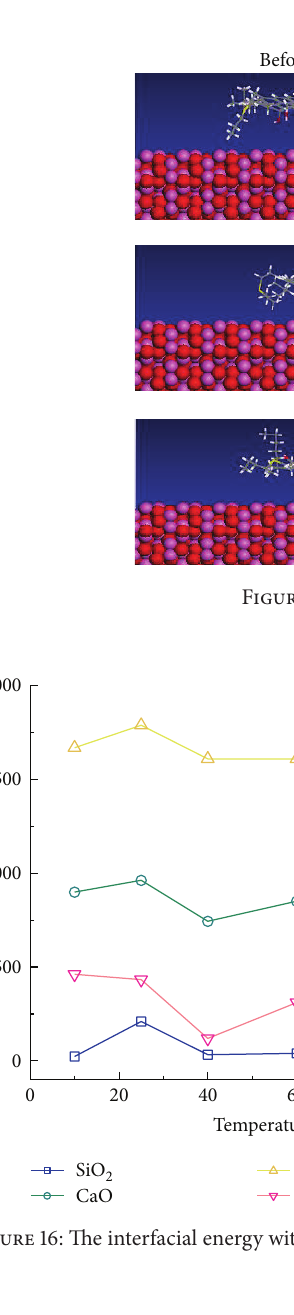
1.61𝐸 + 03 to 1.79𝐸 + 03 kJ/mol, and 1.19𝐸 + 02 to 6.43𝐸 + 02 kJ/mol, respectively. Further, the interfacial energy was plotted in Figure